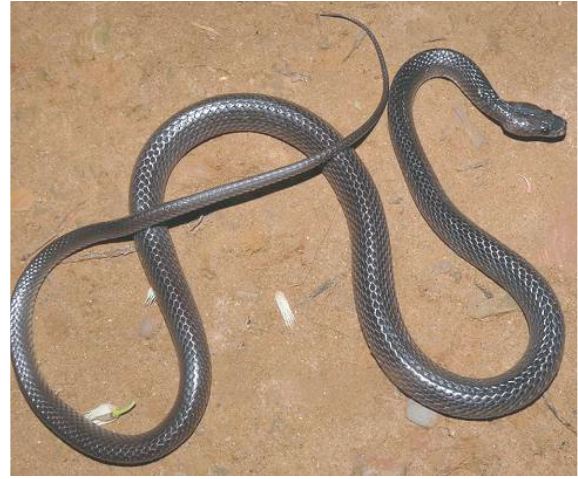
Image 1. Lycodon subcinctus subcinctus Boie, 1827 from Great Nicobar.